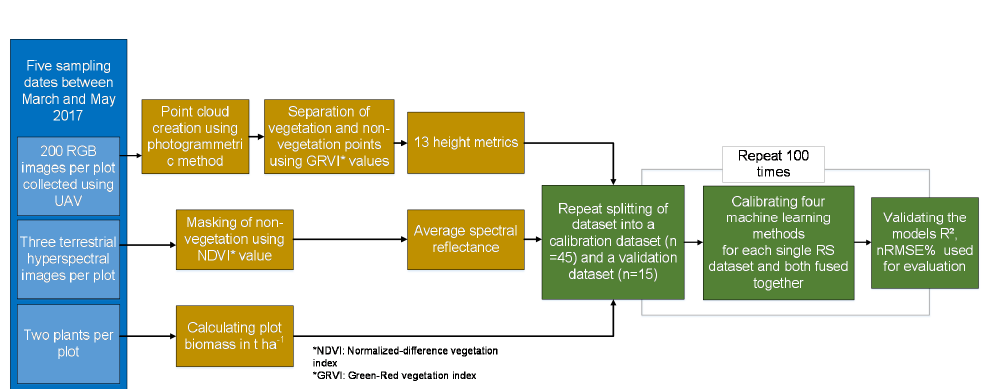
Figure 2. Workflow describing the data collection (blue), data preparation (yellow), and data analysis scheme (green).